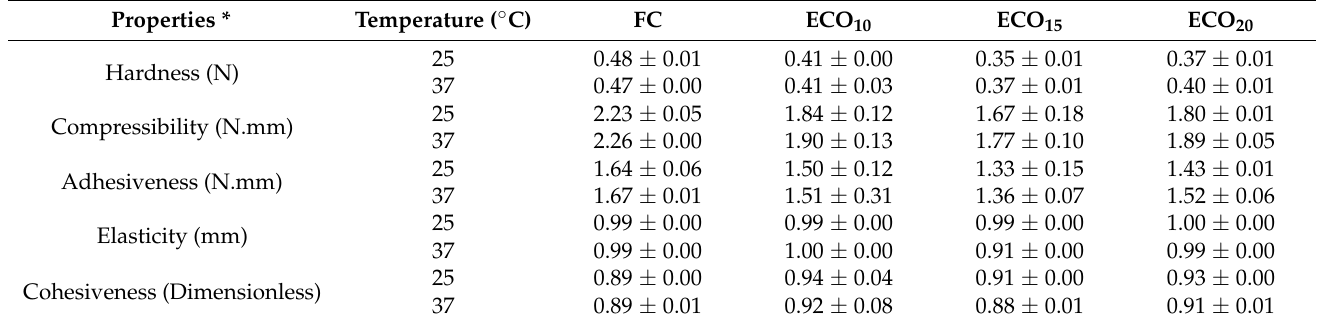
Table 2. Mechanical textural properties (hardness, compressibility, adhesiveness, elasticity, and cohesiveness) of the emulsion-filled gels (EFG).